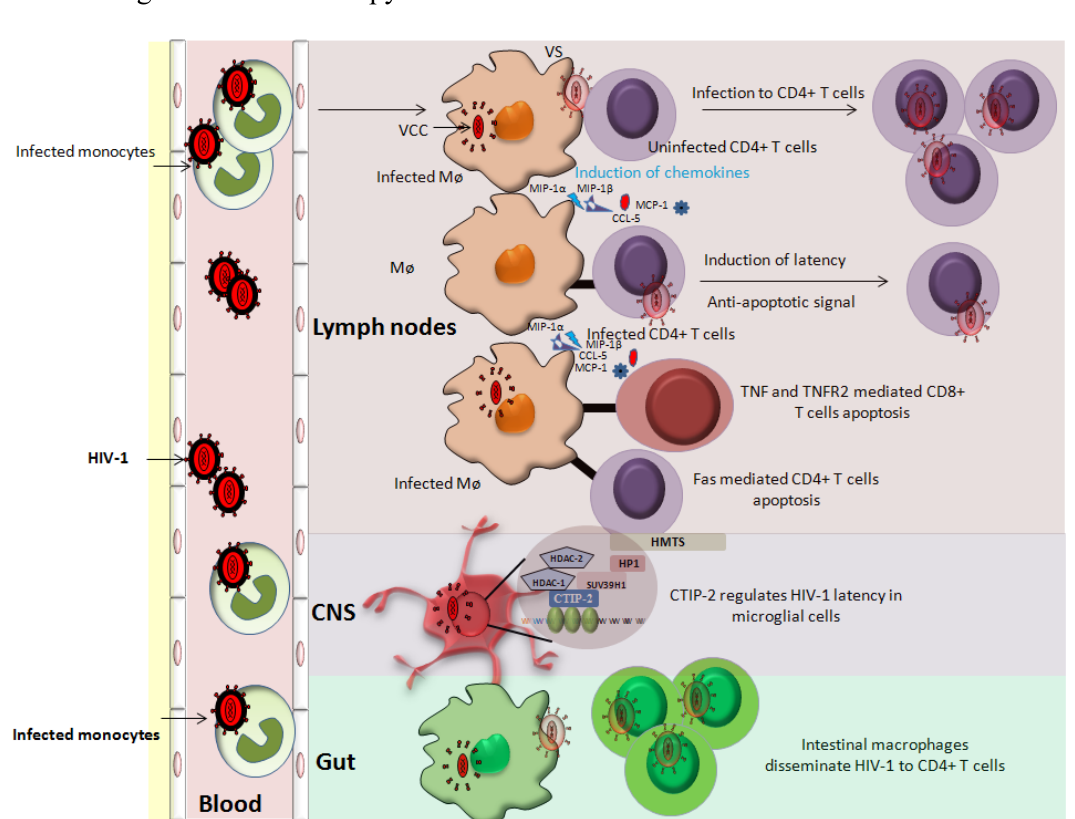
Figure 2. Role of cells of monocyte/macrophage lineage in HIV-1 pathogenesis. Cells